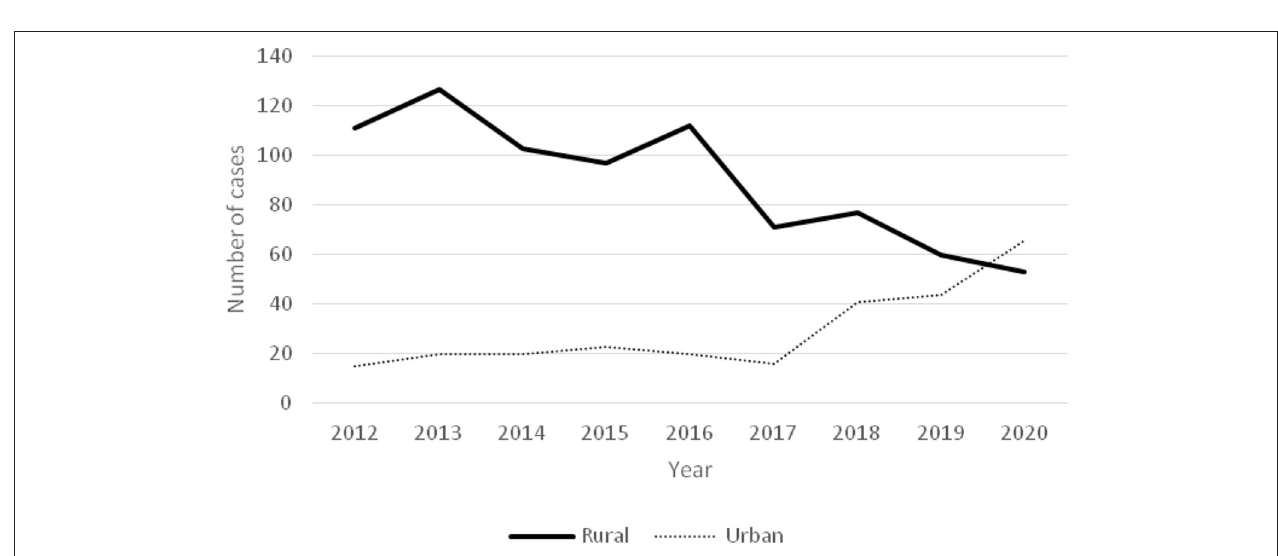
FIGURE 1 | Time-varying curve of the ratio of poisoning in children to total hospital admissions.